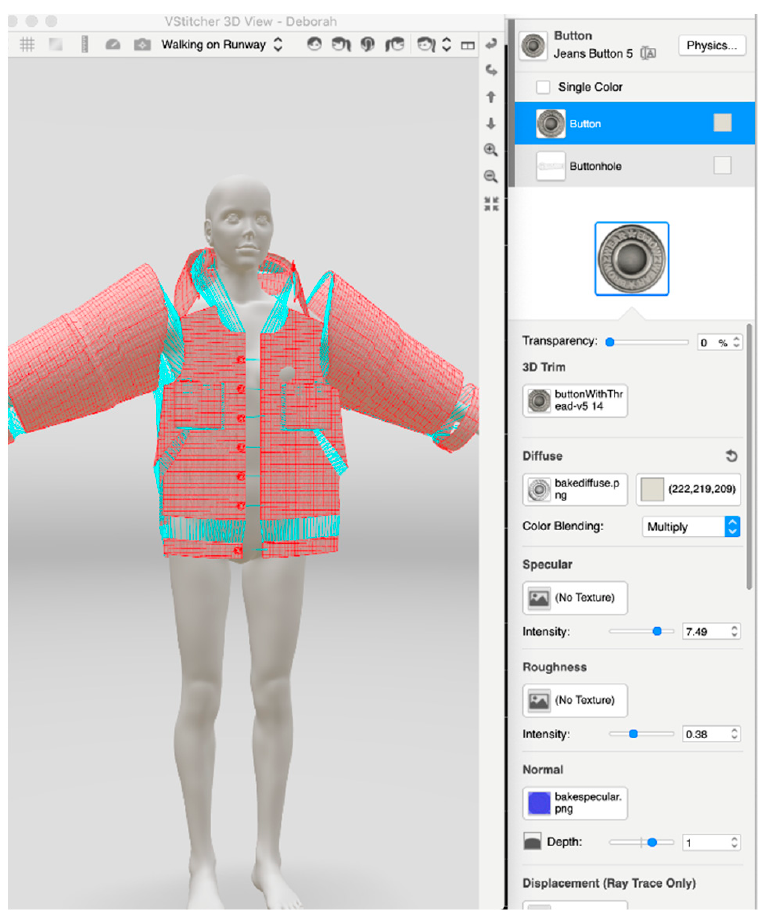
Figure 10. Buttons imported in the garment of Figure 10 as digital images.